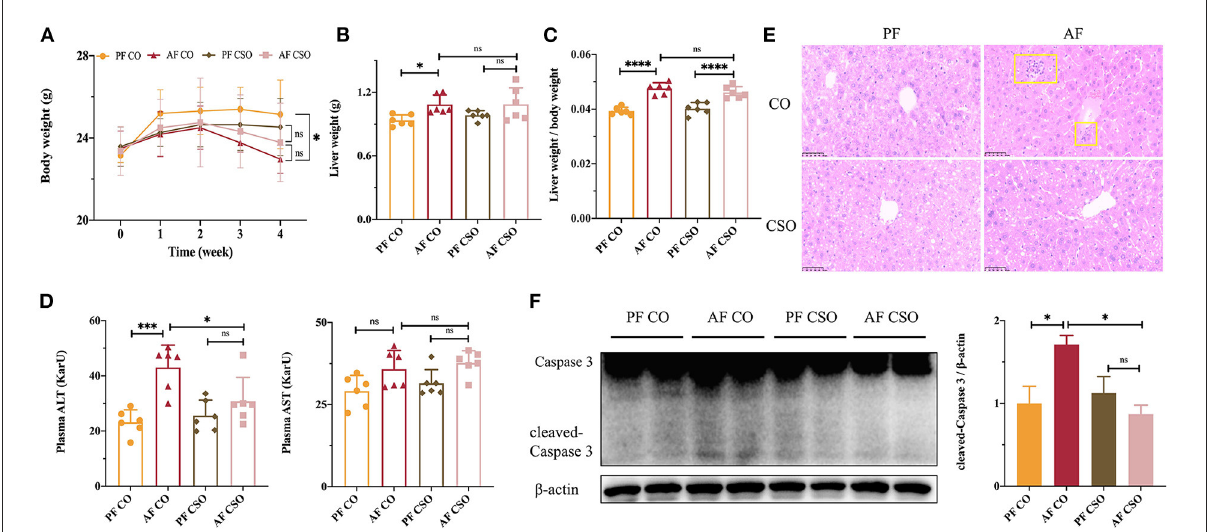
FIGURE1 Dietary CSO supplementation rescues alcohol-induced liver injury. (A) The body weight. (B) The liver weight. (C) The ratio of liver-to-body weight. (D) The activities of plasma ALT and AST. (E) H&E staining (400 × ). (F) The expression of hepatic cleaved-Caspase 3. * P < 0.05, *** P < 0.001, and **** P < 0.0001 indicate statistically